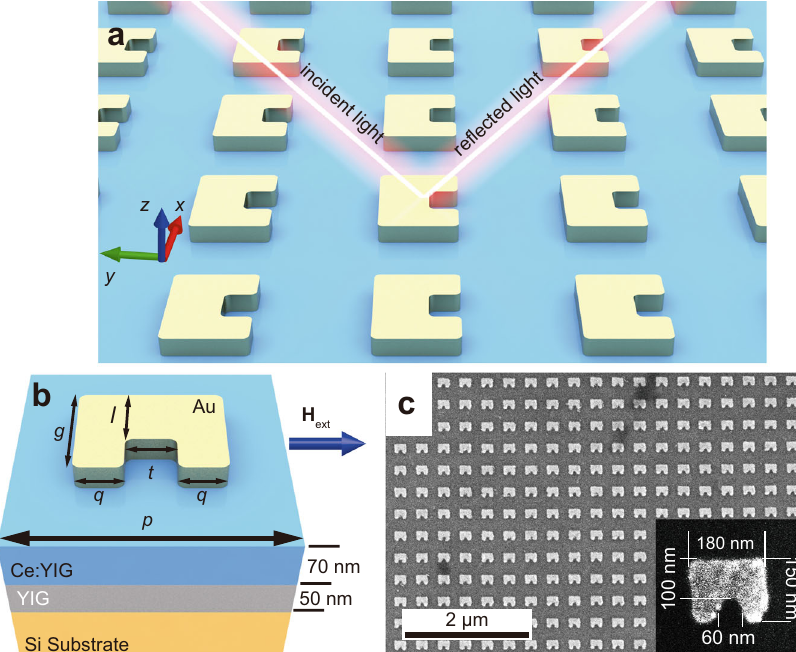
Fig. 1 Schematic and geometric morphology of the device. a Schematic diagram of the MO-SRR metamaterial. b Schematic of a unit cell of the MO-SRR metamaterial with an Au-SRR on top of the Ce:YIG fi lm (blue), YIG fi lm (gray), and silicon substrate (Orange). The p , g , q , l , t are the period of the unit cell, length of vertical arm, width of vertical arm, width of horizontal arm, and width of the gap, respectively. c SEM images of the MO-SRR